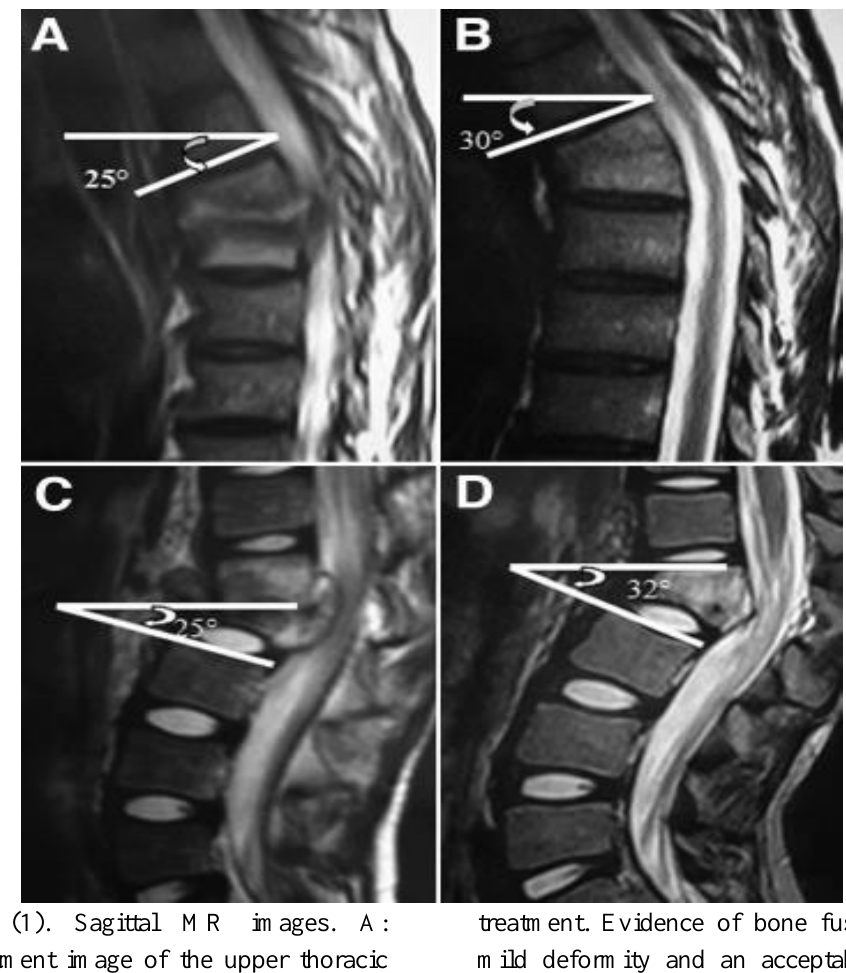
Figure (1). Sagittal MR images.